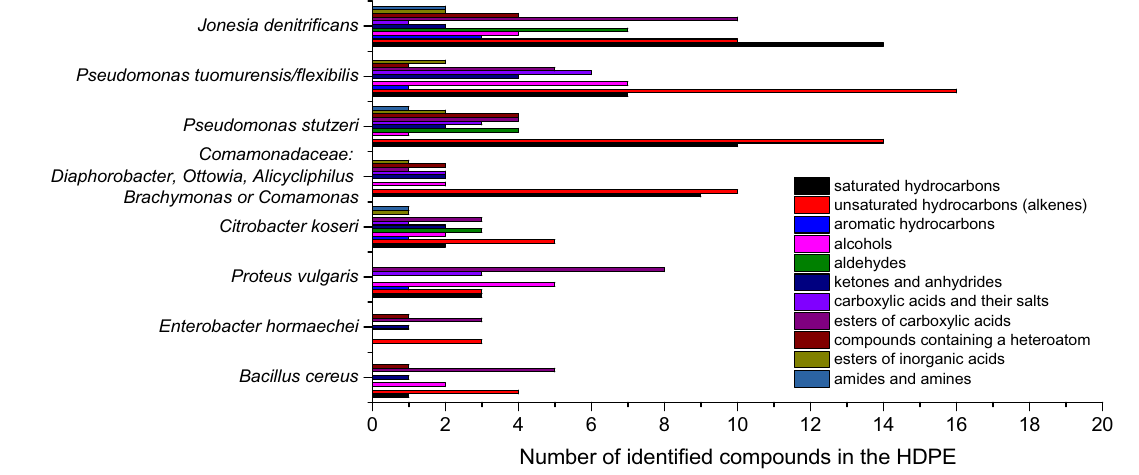
Fig. 5 Overview of the groups of biodegradable compounds found in the organic matter around the surface of HDPE after degradation with all tested bacterial species